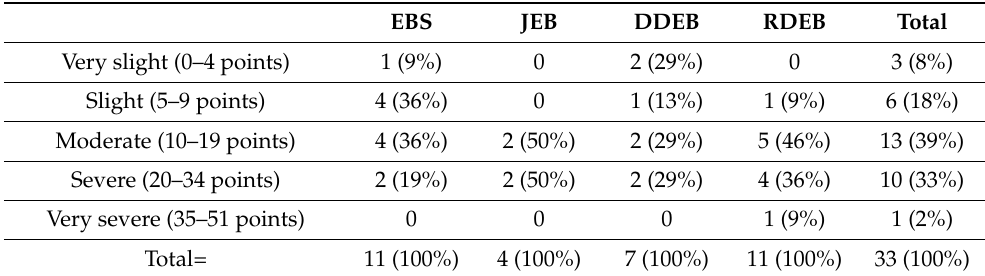
Table 3. Impact on quality of life by EB subtype, according to the results obtained from Spanish version of the QoLEB